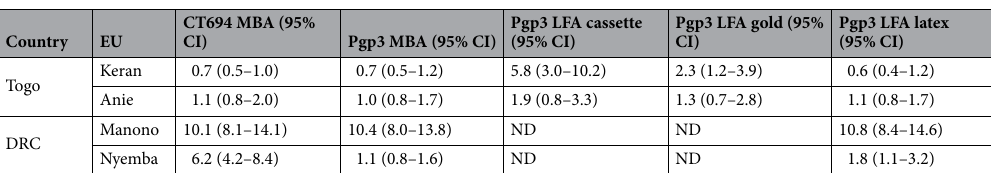
Table 2. Seroconversion rates (SCR) by different immunoassays. EU evaluation unit, CI confidence interval, Pgp3 plasmid gene product 3, CT Chlamydia trachomatis, MBA multiplex bead assay, LFA lateral flow assay, ND not